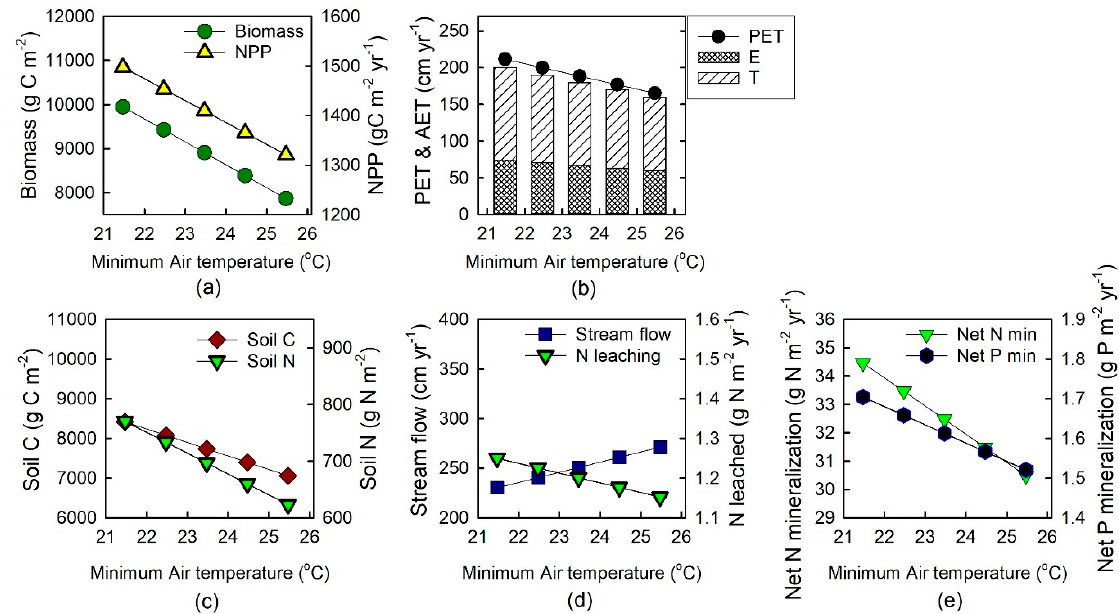
Figure 2. Model output from sensitivity analyses to evaluate effects of increased night-time